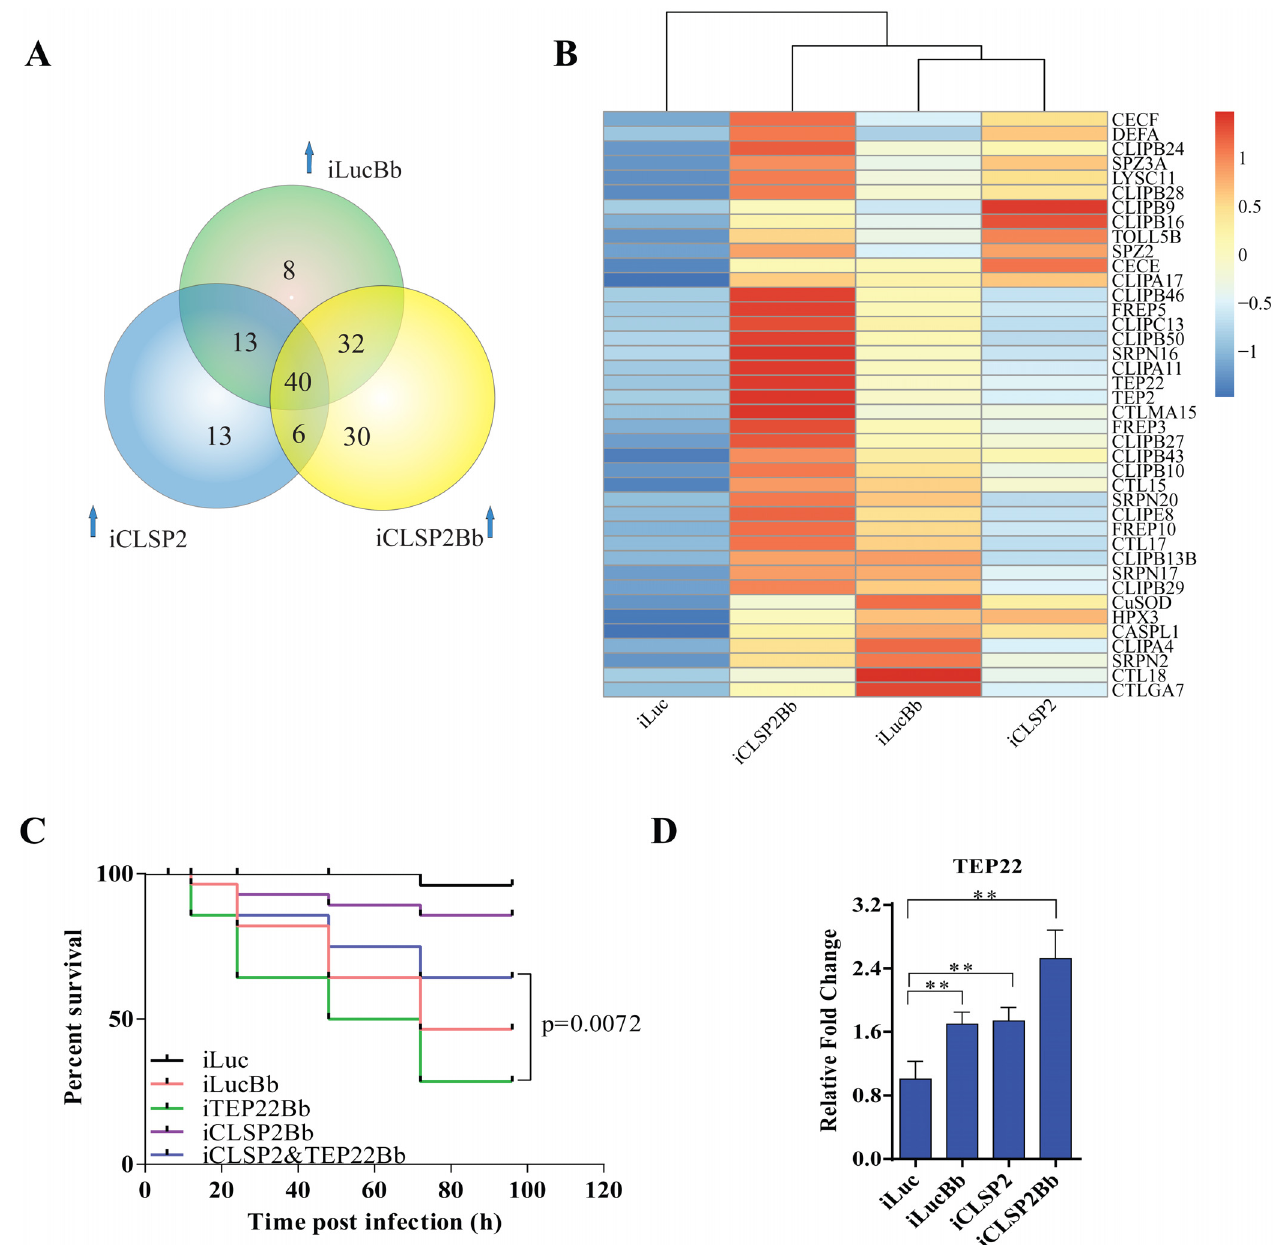
Fig 4. Comparative transcriptome analysis of CLSP2 modulation of immune genes and the role of TEP22 in anti-fungal defense. A ) Venn diagram representing unique and shared up-regulated immune genes (1.5 fold changes compared with control) in iLucBb, iCLSP2, and iCLSP2Bb mosquitoes. B ) Expression profiles of immune genes that are concurrently up-regulated in iLucBb, iCLSP2, and iCLSP2Bb mosquitoes. Transcript abundance of each gene was calculated using the RSEM software package (Trinity) and heat maps generated by R software. The color scale indicates the abundance deviation from the median for each gene. Expression levels of common up-regulated genes are also shown in S4 Table. C ) The survival rate of mosquitoes showed that concomitant depletion of TEP22 and CLSP2 (iCLSP2&iTEP22Bb) enhanced the capacity of mosquitoes to defend B . bassiana (p < 0.01) compared with single depletions of iTEP22Bb, or control iLucBb. Each experiment was performed in three replicates. Green line — iTEP22Bb, TEP22 dsRNA-treated mosquitoes infected with B . bassiana ; purple line — double knockdown iCLSP2&TEP22 mosquitoes infected with B . bassiana ; blue line — iCLSP2 mosquitoes injected with B . bassiana conidia; red line — iLucBb, iLuc mosquitoes injected with the fungus; black line — iLuc control mosquitoes. D ) mRNA abundance of TEP22 was up-regulated in iCLSP2Bb mosquitoes. Normalized expression level of iLuc was shown. Data were shown as mean ± SEM. * p < 0.05; ** p < 0.01. iLucBb, iLuc mosquitoes infected with B . bassiana (24 h post infection); iCLSP2, CLSP2 dsRNA-treated mosquitoes infected with B . bassiana (24 h post infection); iCLSP2, mosquitoes injected with CLSP2 dsRNA. Control group (iLuc) was injected with luciferase dsRNA.